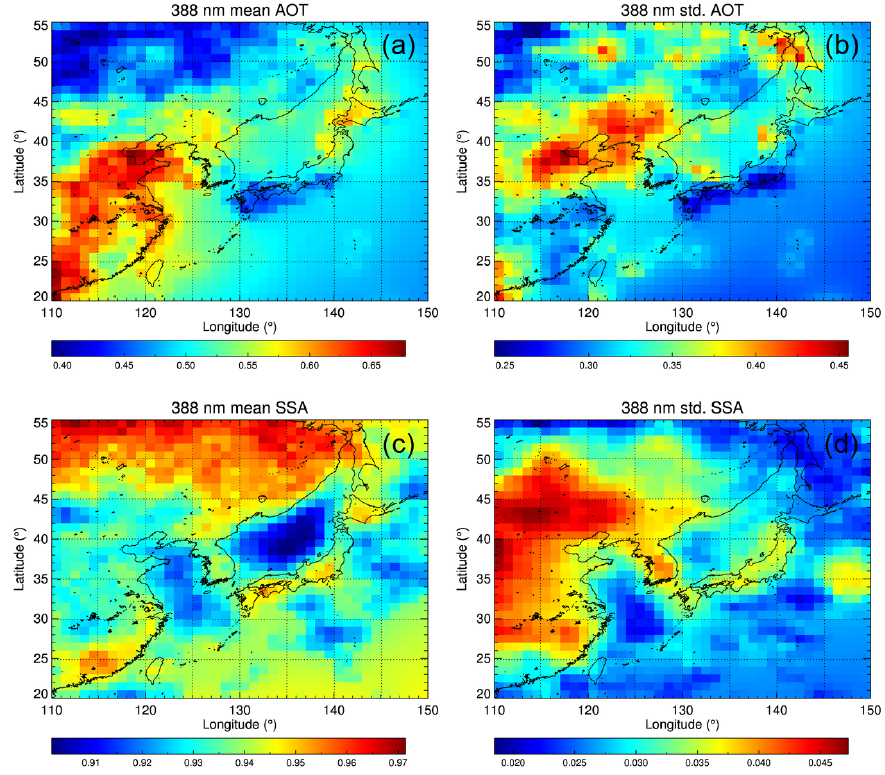
Figure 2. (a) Mean and (b) standard deviation of 388nm AOT from the OMAERUV product in spring (March to May) 2005–2014. Panels (c) and (d) show the average and standard deviation of SSA, respectively, during the same